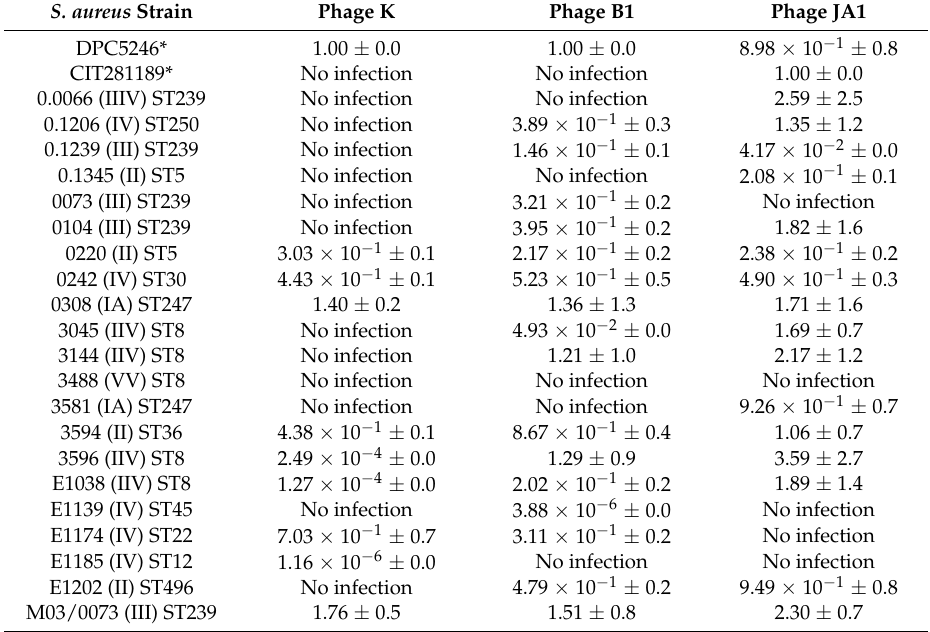
Table 2. Host ranges of staphylococcal phages B1, JA1, and K against methicillin-resistant Staphylococcus aureus (MRSA) strains from the Irish National Reference Laboratory (St. James’s Hospital Dublin, Ireland) including the efficiency of plaquing (EOP) of these strains.